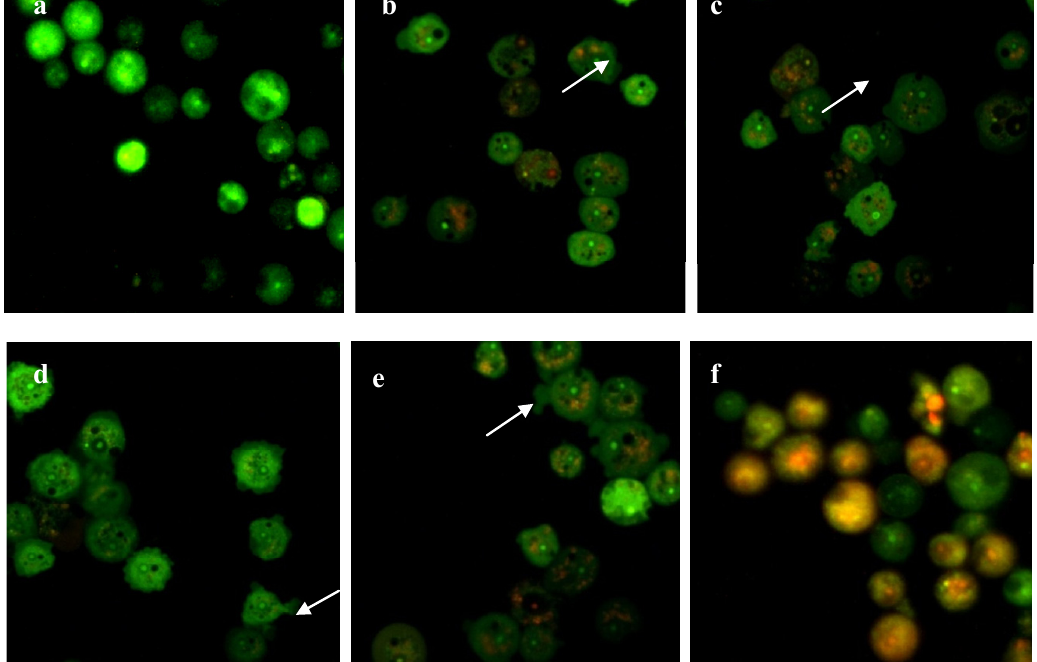
Figure 4. Fluorescence micrographs of A. polyphaga stained with AO/PI. ( a ) Untreated cells; ( b ) M1 -treated cells; ( c ) M2 -treated cells; ( d ) M3 -treated cells; ( e ) M4 -treated cells; ( f ) Chlorhexidine-treated cells. Membrane blebbings were observed in all compound-treated amoebae (arrows). Magnification